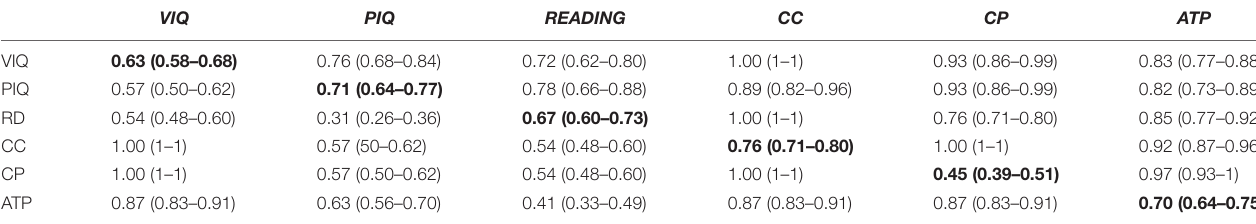
TABLE 4 | Genetic correlations, heritabilities, and proportions of phenotypic correlations accounted for by genetic factors with 95% confidence intervals. VIQ PIQ READING CC